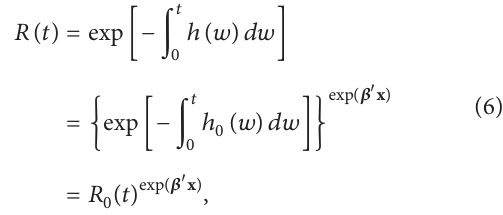
Figure 1: Photograph of bicyclists’ crossing at Z-T